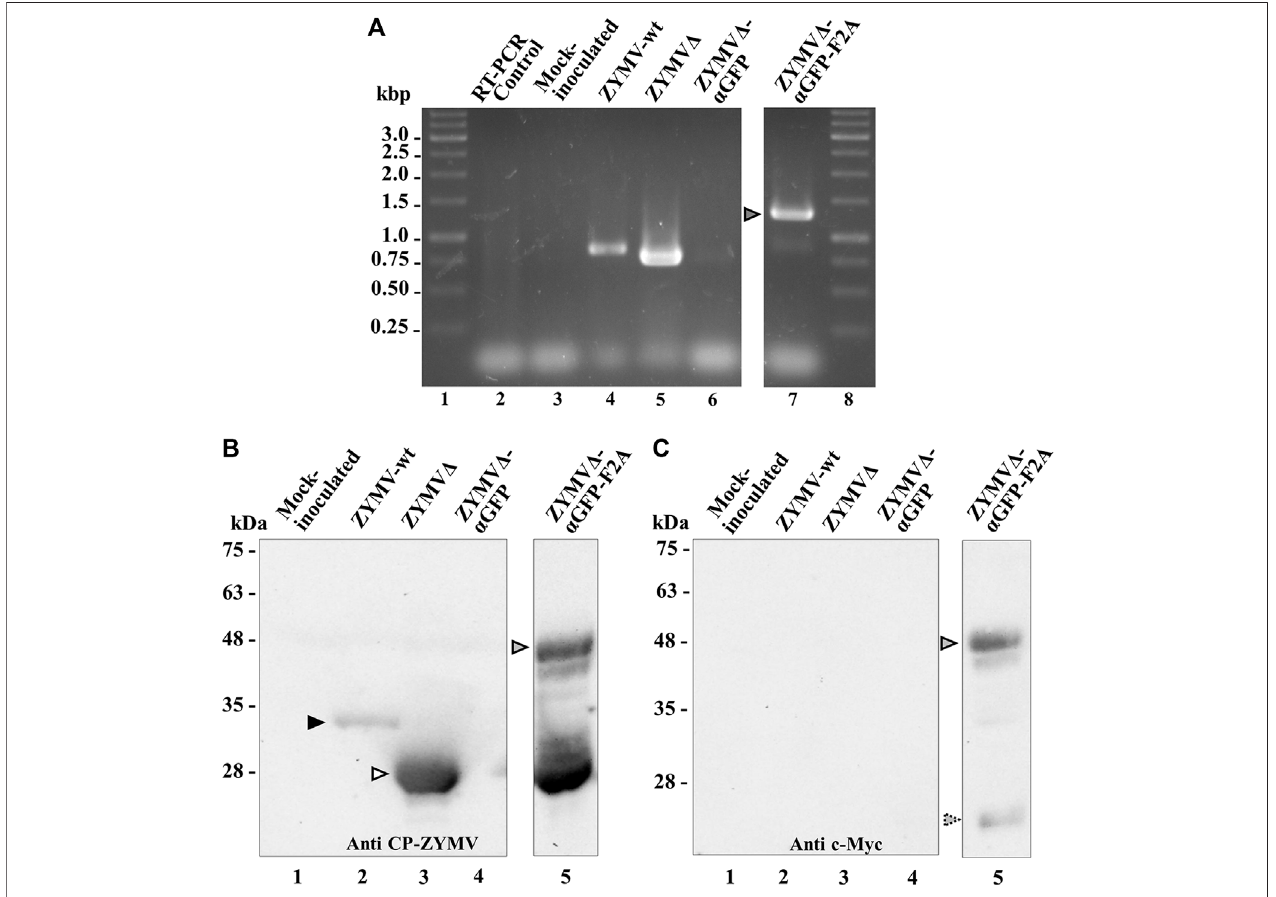
FIGURE 3 | Analysis of zucchini tissues from plants inoculated with various ZYMV-derived recombinant clones at 21 dpi. (A) RT-PCR analysis of the progeny of recombinant ZYMV inoculated into zucchini plants. Representative samples from triplicate-inoculated plants are shown. Ampli fi cation products corresponding to the ZYMVCPregionwereseparatedviaelectrophoresisinanagarosegel,whichwasstainedwithethidiumbromide.Lanes1and8,DNAmarkerladderwithsizes(inkbp)in theleft; lane2,RT-PCR controlwithno RNAadded;lane3,mock-inoculatedplant; lanes 4to7,plants agroinoculatedwithZYMV-wt, ZYMV Δ ,ZYMV Δ - α GFP,and ZYMV Δ - α GFP-F2A, respectively. (B and C) Western blot analyses of protein extracts using an antibody against (B) ZYMV CP and (C) the c-Myc epitope fused to the α GFPnanobody.ProteinswereseparatedbySDS-PAGEandtransferredtoamembrane.Lane1,mock-inoculatedplant;lanes2to5,plantsagroinoculatedwithZYMV- wt, ZYMV Δ , ZYMV Δ - α GFP, and ZYMV Δ - α GFP-F2A, respectively. The positions and sizes of protein standards are indicated on the left. Black and white arrowheads indicatethepositionsofZYMVCPandCP Δ ,respectively.Grayandstrippedarrowheadsindicatesthepositionofthe α GFP-F2A-CP Δ fusionandfree α